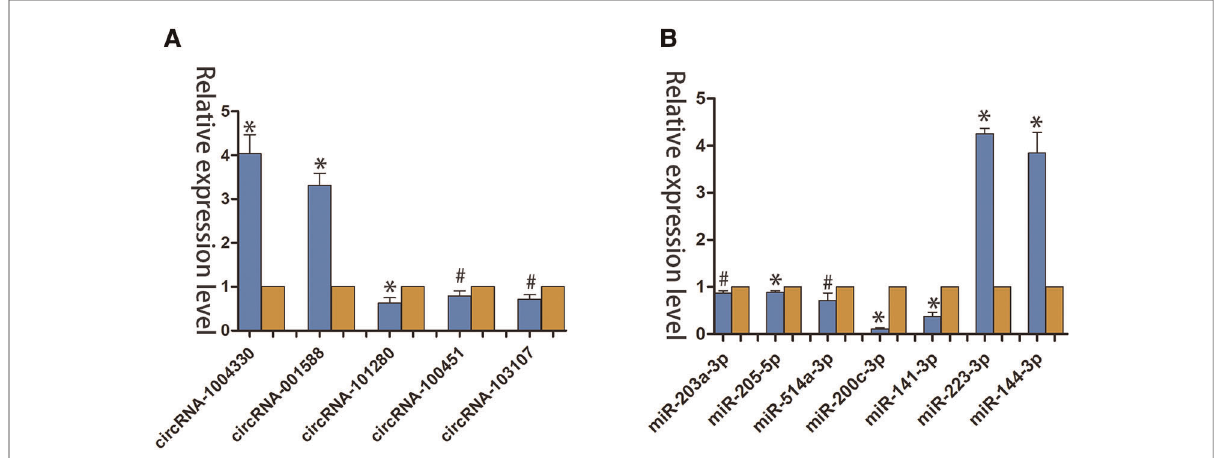
FIGURE 2 qRT-PCR veri fi ed the differential expression of circRNAs and miRNAs in Normal tissues and diabetic wounds. ( A ) Differential expression of circRNAs in different tissues. (* p <0.01, # p <0.05) ( B ) Differential expression of miRNAs in different tissues (* p <0.01, # p <0.05).(yellow indicates NC; blue indicates case.).